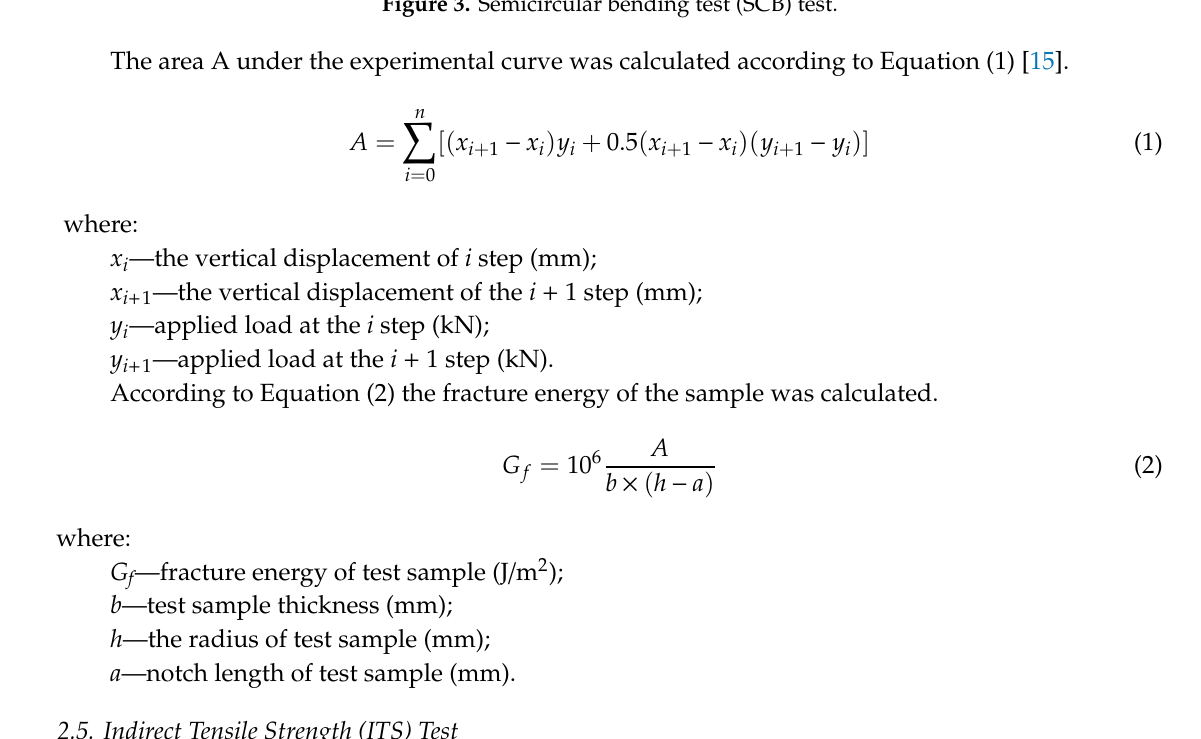
Figure 3. Semicircular bending test (SCB)